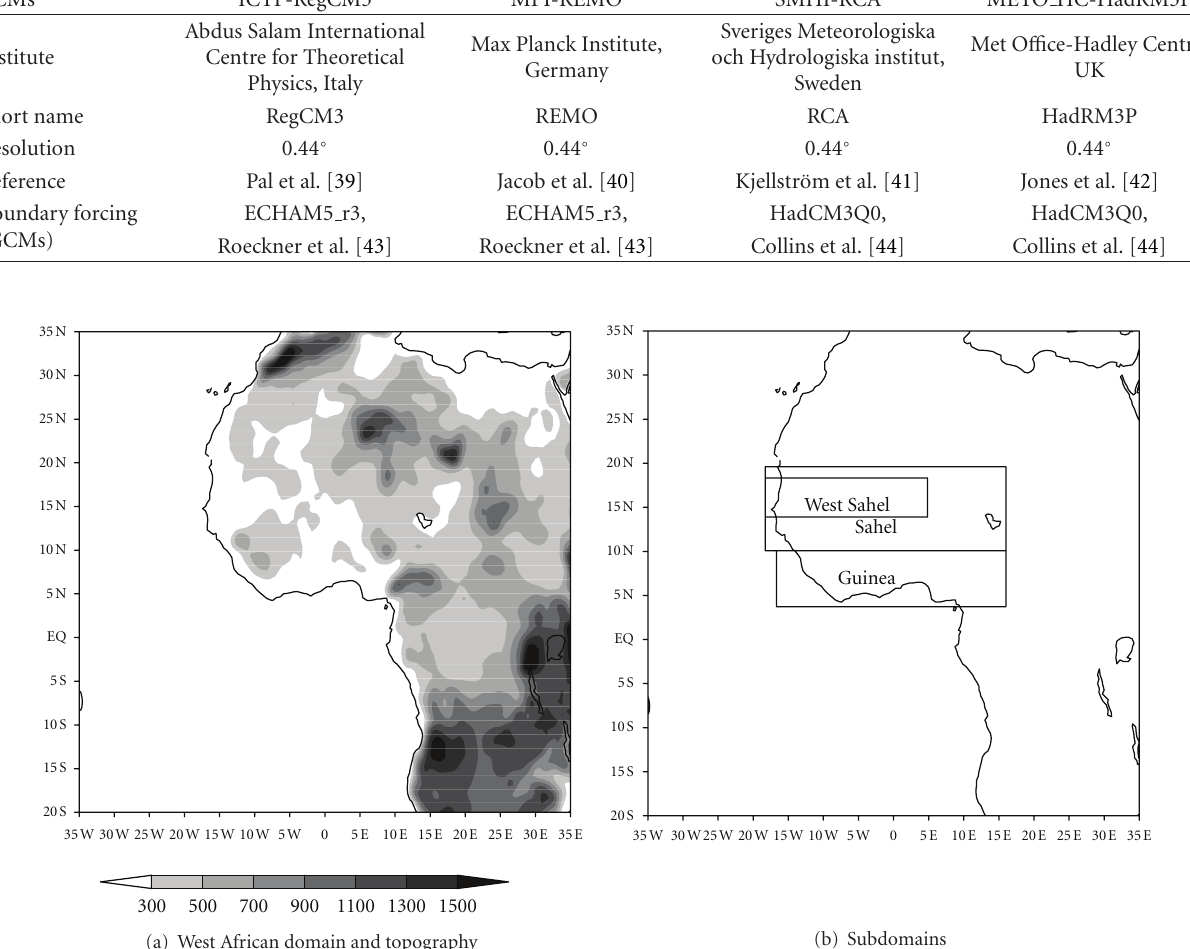
Figure 1: AMMA domain and topography (a) Sahel, Guinea, West Africa, and Western Sahel subdomain considered for analyses through the paper